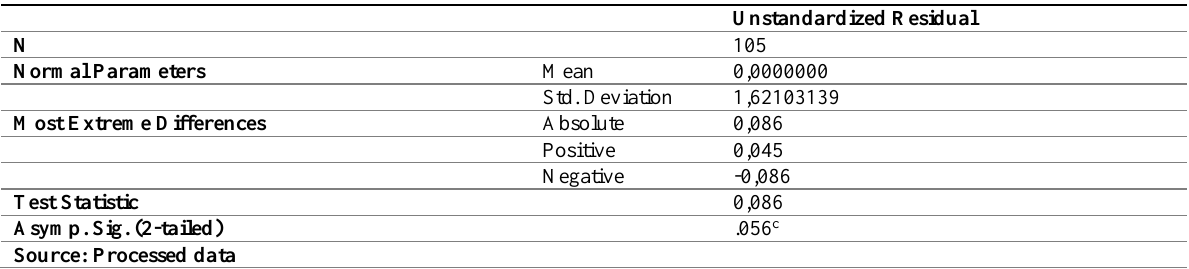
Table 8: Normality Test Results